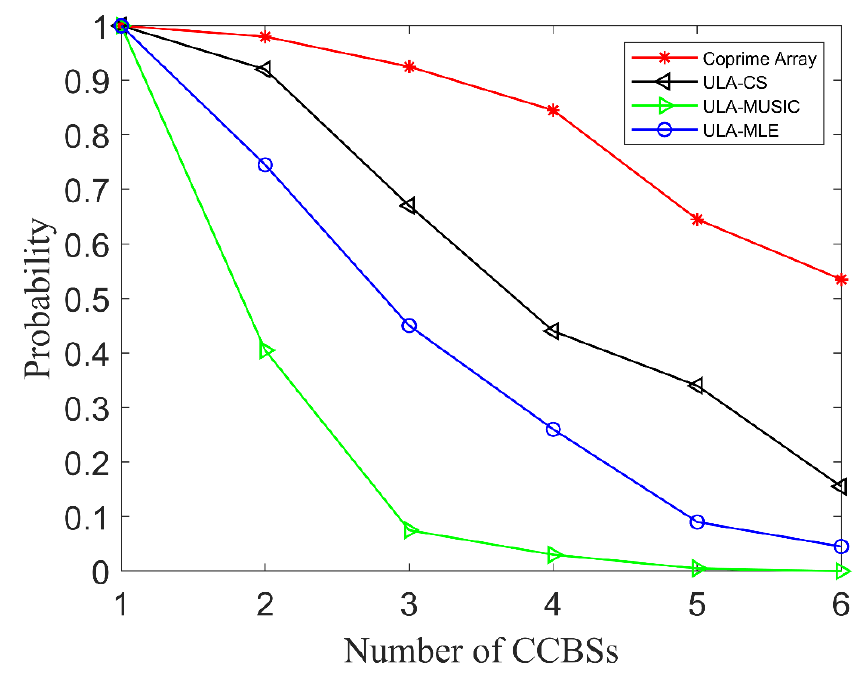
Figure 9. All CCBSs estimate the correct probability.